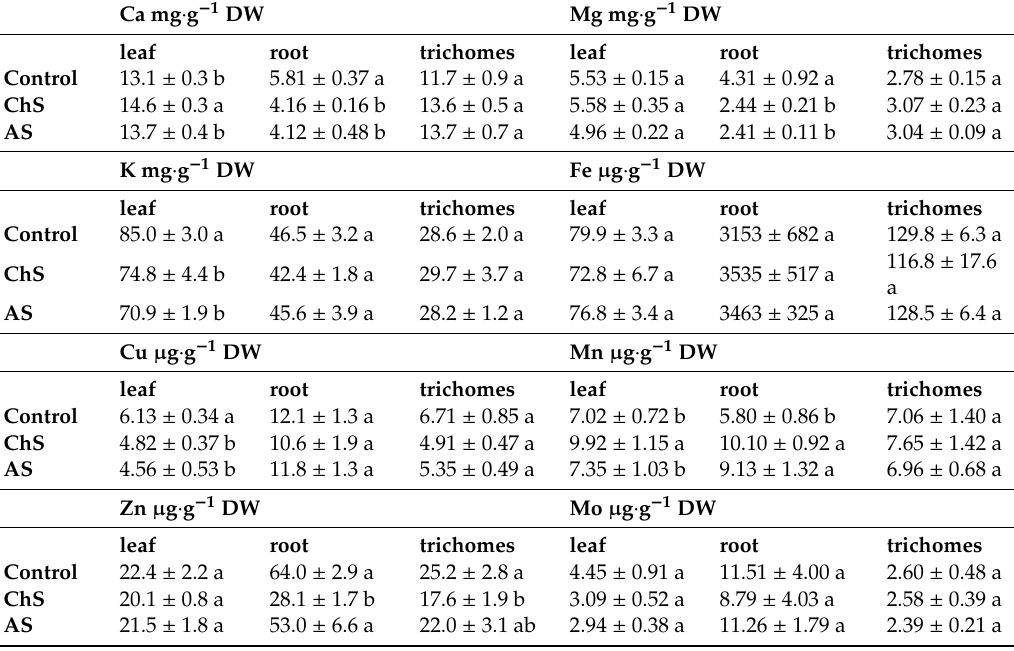
Table 1. Accumulation of selected mineral nutrients in the leaves (without trichomes), roots,